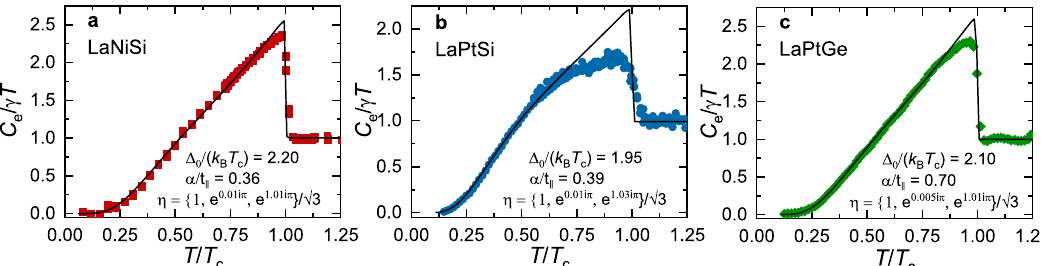
Fig. 6 Electronic speci fi c heat. a – c Normalized electronic speci fi c heat C e / γ T (with γ the normal-state electronic speci fi c-heat coef fi cient) as a function of the reduced temperature T / T c for LaNiSi ( a ), LaPtSi ( b ), and LaPtGe ( c ). C e / T was determined by subtracting the phonon contribution from the raw speci fi c-heat data (see Supplementary Fig. 10 and Note 7). Solid lines through the data represent theoretical calculations corresponding to the INT state with the fi t parameters listed in the fi gures. For LaPtSi, the reduced speci fi c-heat jump at T c is mostly caused by the broadening of the superconducting